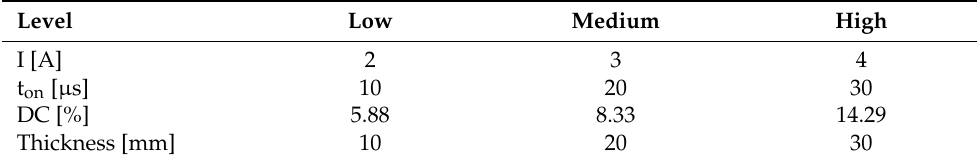
Table 3. Investigated process parameters and their levels.